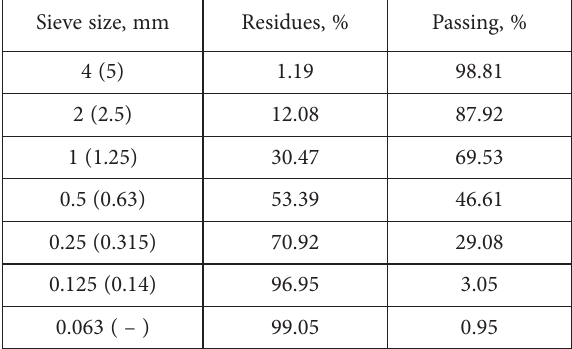
Table 3. The results of grading